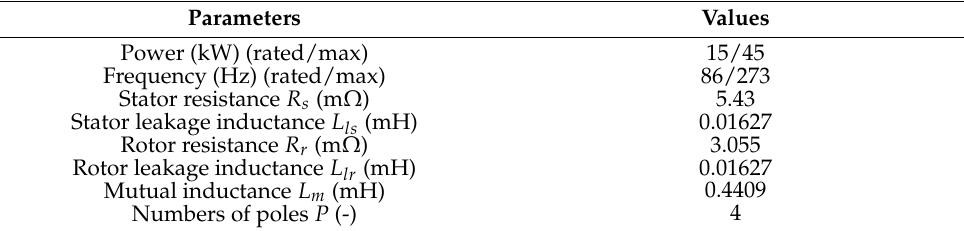
Table 2. Induction motor